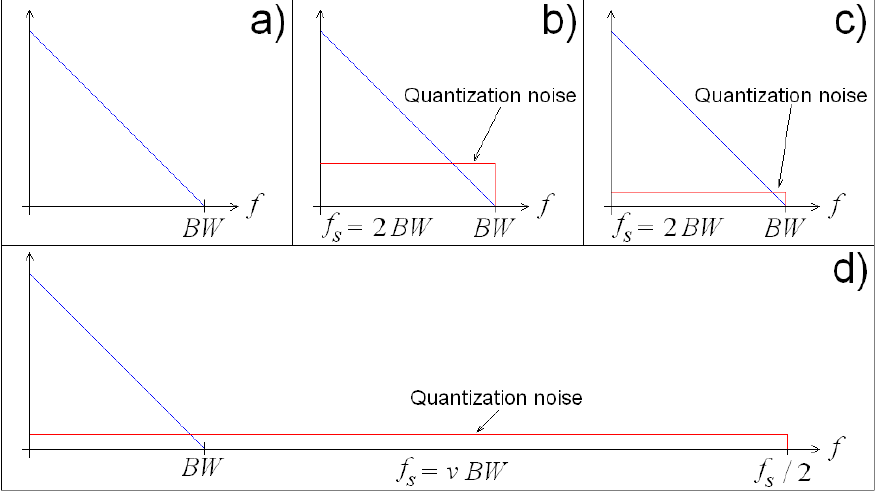
Figure 3. Signal spectra. (a) Noiseless. (b) n -bit resolution at Nyquist rate. (c) Increased resolution at Nyquist rate. (d) v -times oversampled with n -bit